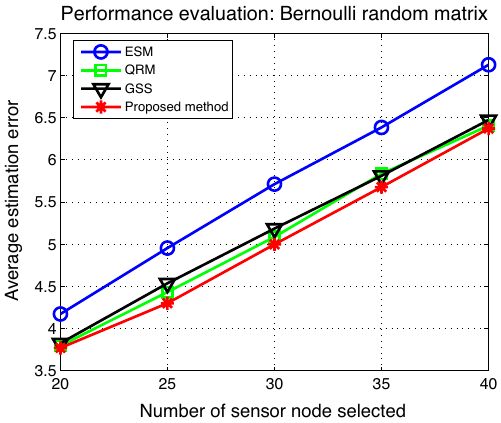
Fig. 2 Estimation performance with respect to various parameter dimensions for Bernoulli random matrix H : the proposed algorithm is compared with different selection methods by varying the dimension of the parameter, | S | =